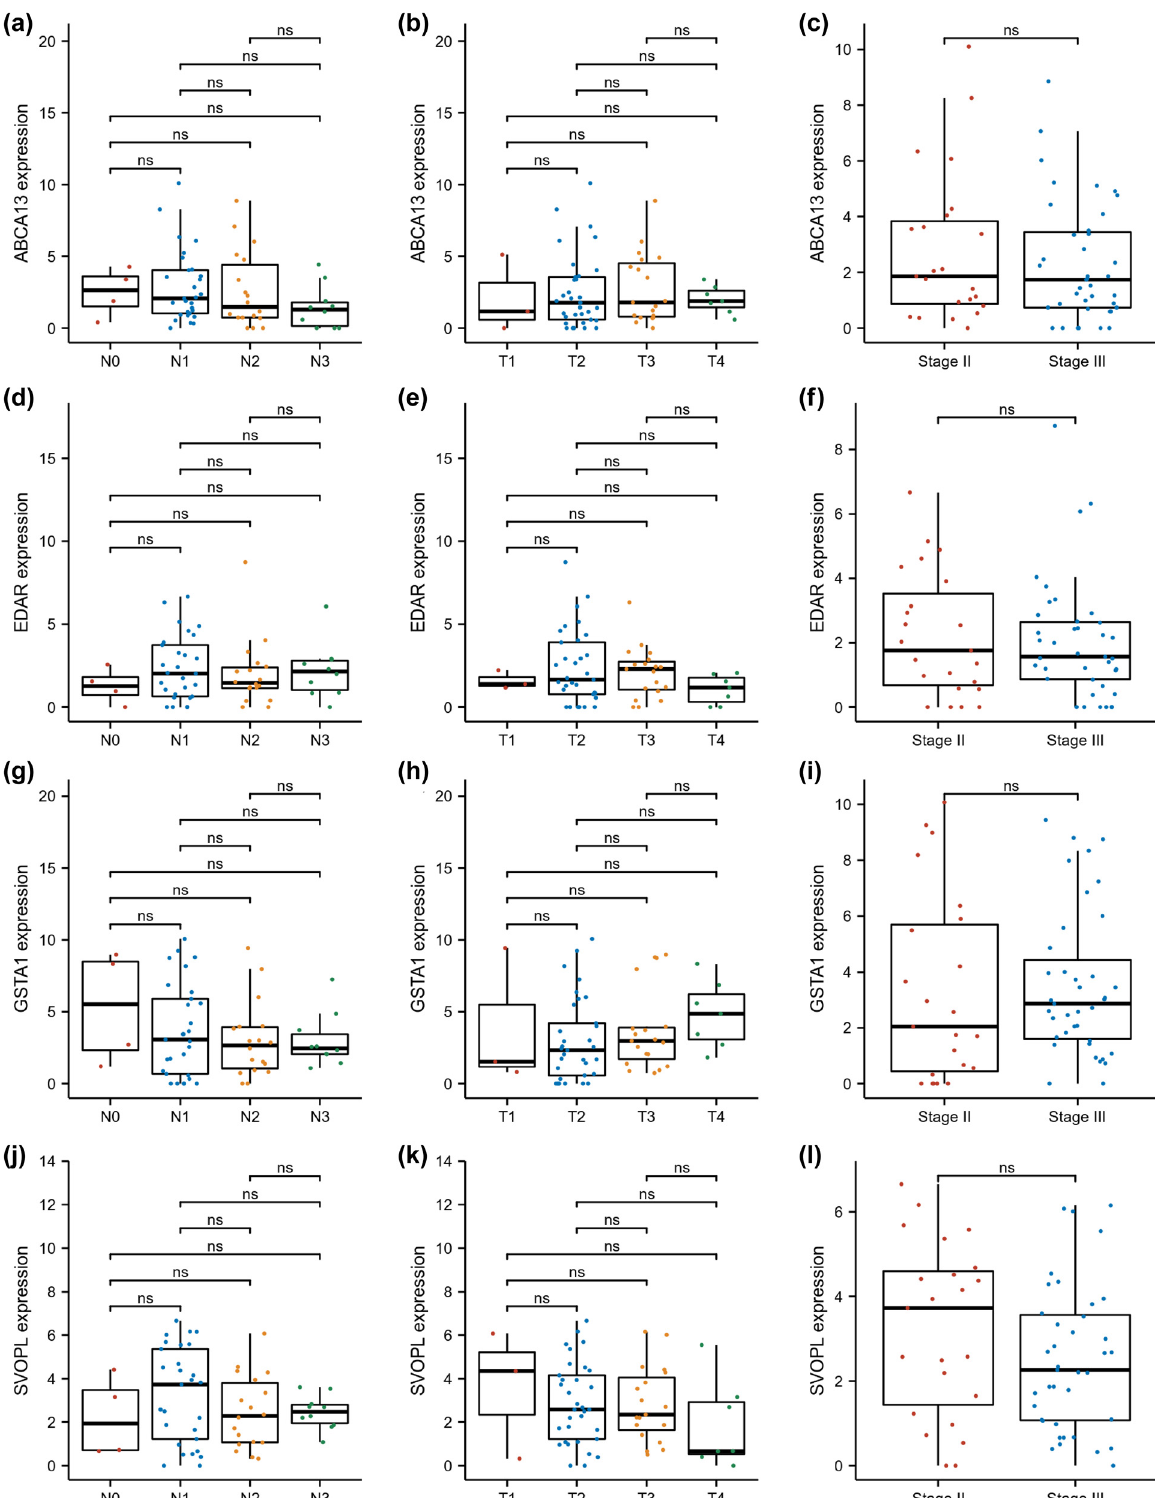
Figure A1: Association between ABCA13, EDAR, GSTA1, and SVOPL expression and tumor stage of breast